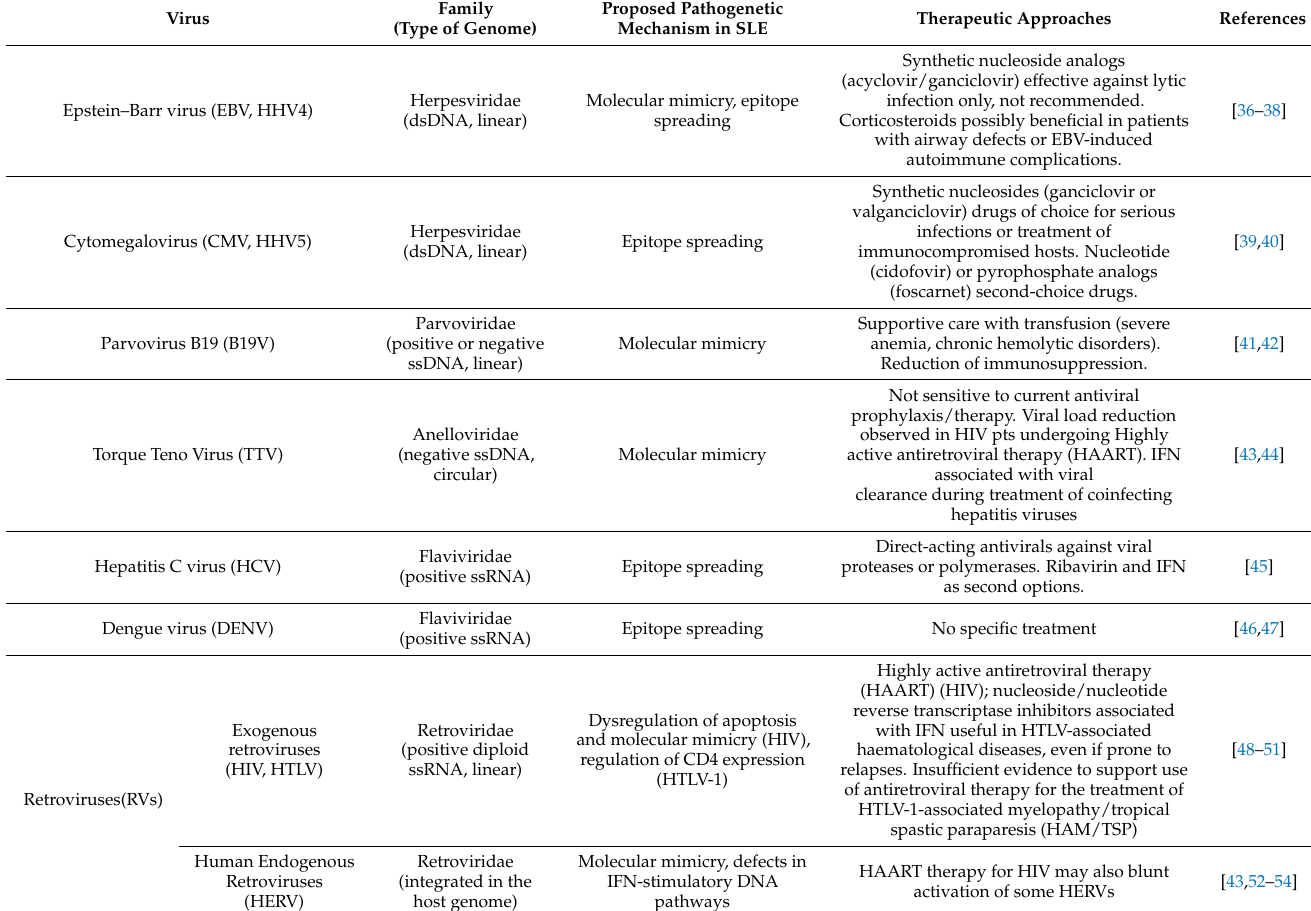
Table 2. General features of the viruses putatively involved in systemic lupus erythematosus (SLE) pathogenesis. Virus Family (Type of